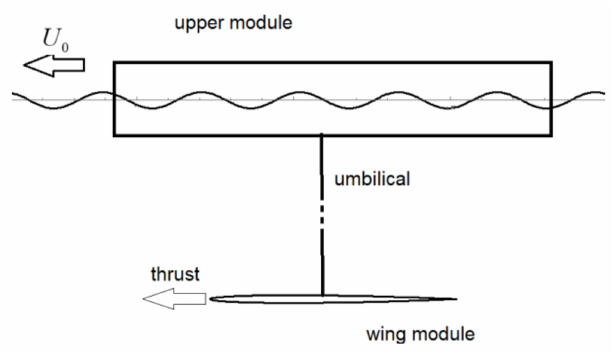
Figure 10. Schematized wave